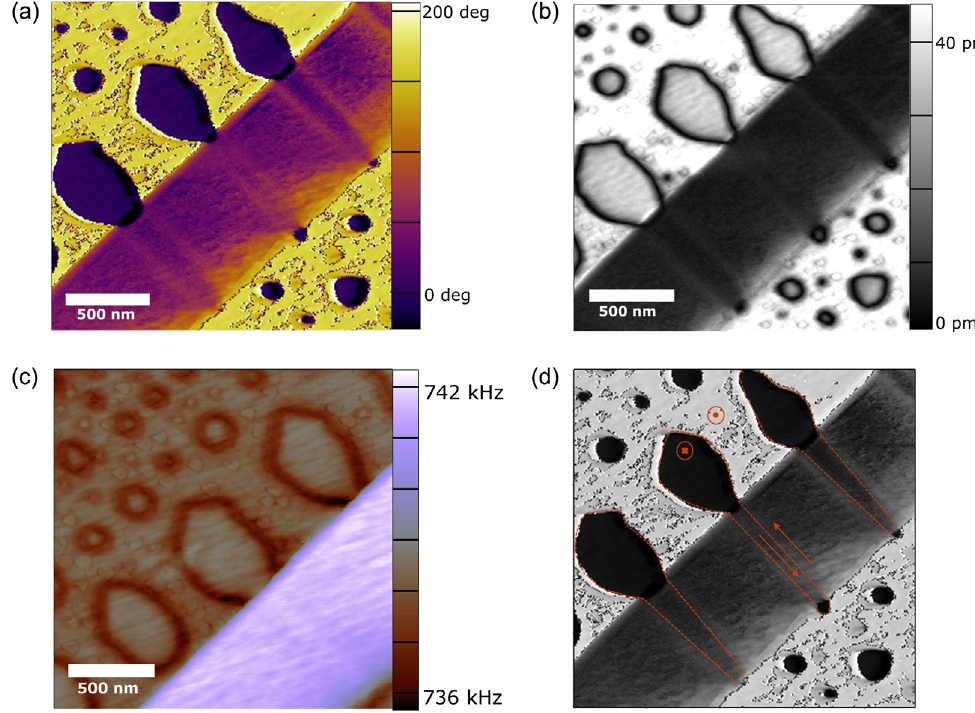
FIG. 3. (a) Vertical PFM phase of BaTiO 3 single crystal spontaneously polarized, where the opposite out-of-plane polarization of the crystal is shown. (b) Vertical PFM amplitude of the crystal, where the in-plane polarization is denoted. (c) CRFM image of the same area where there is no difference in frequency contrast due to in-plane polarization. (d) Schematic representation of in-plane